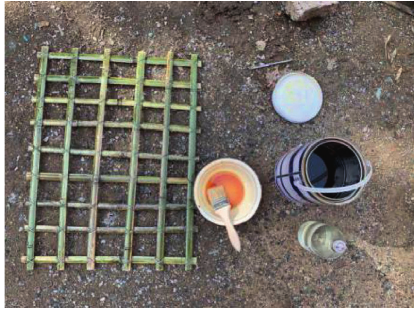
Figure 5: Bamboo